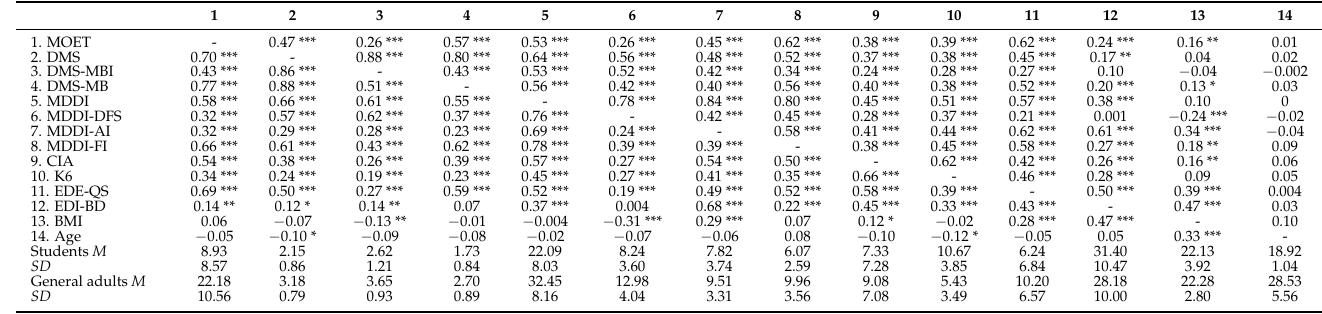
Table 5. Correlations among the variables included in the current study.